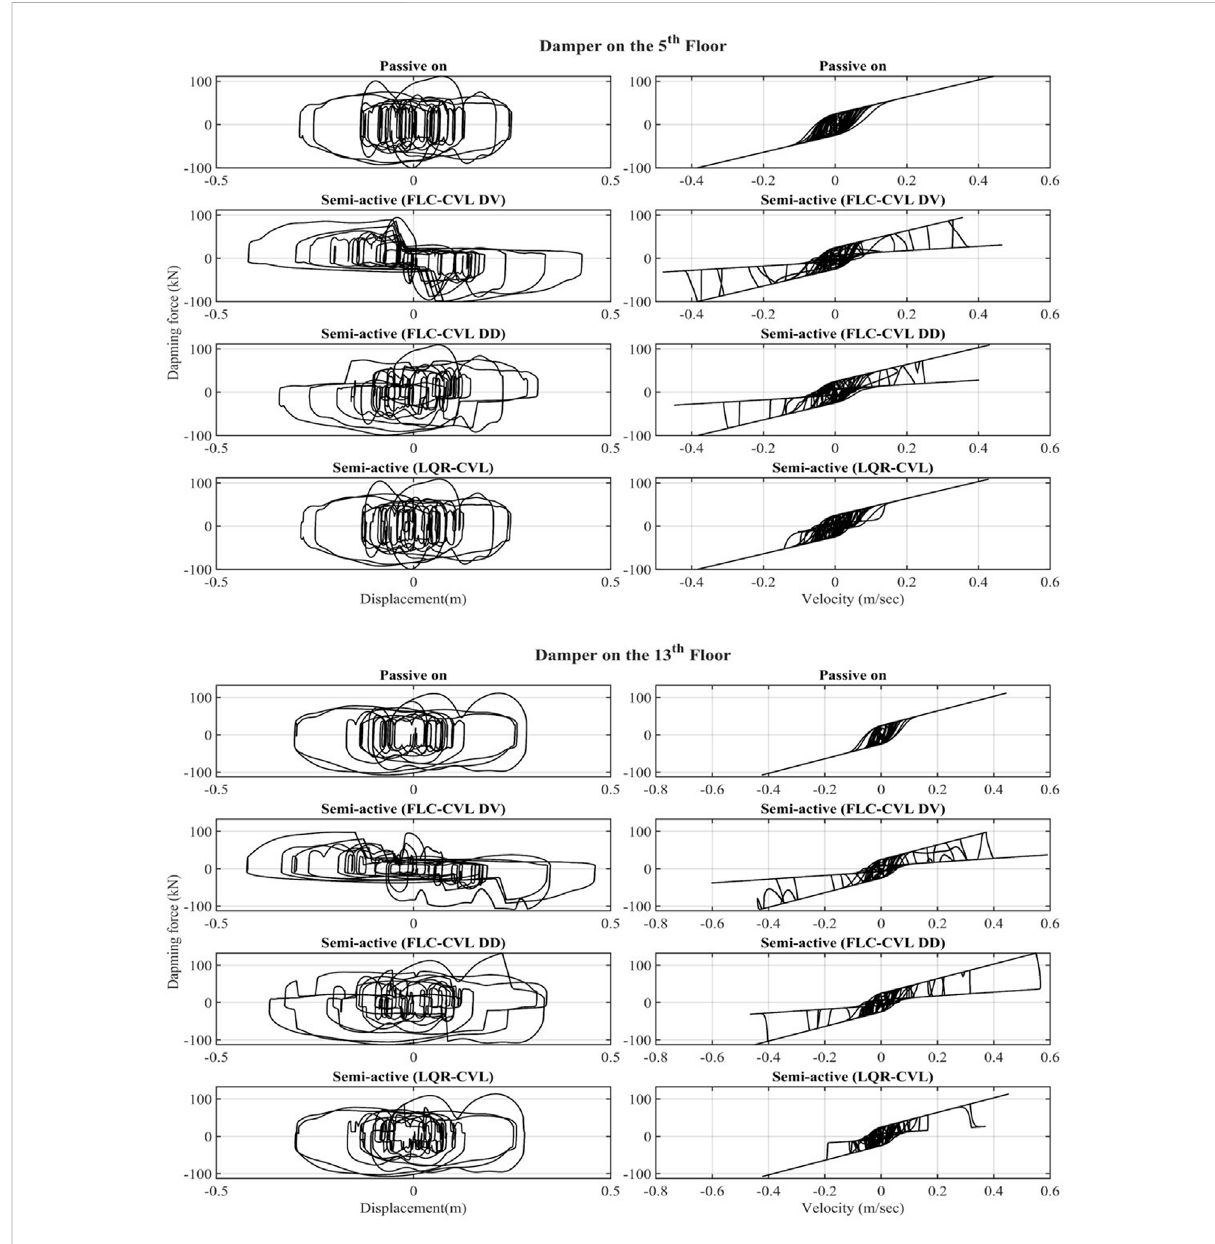
FIGURE 13 Hysteresis behavior of MR dampers under Taft (PGV = 0.5 m/s), 1952.